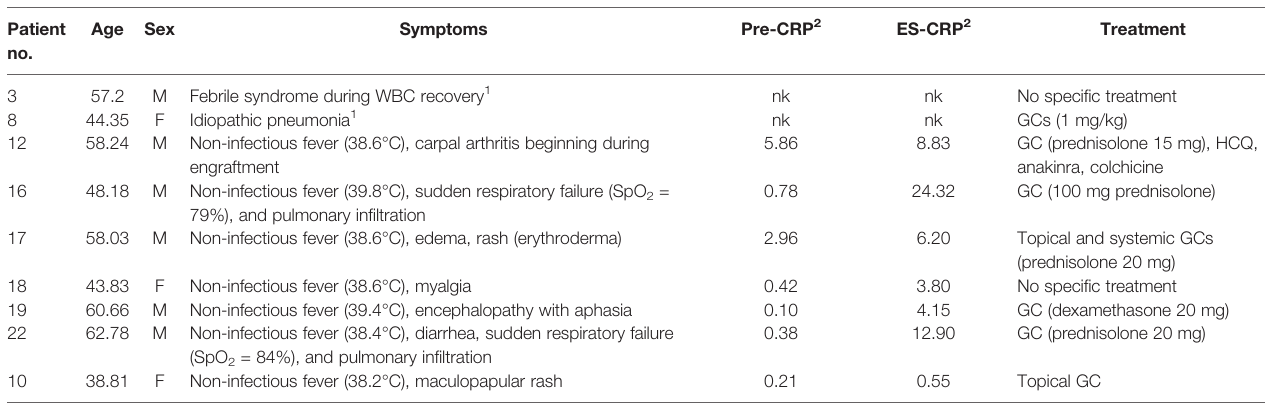
List of all patients with engraftment syndrome sorted by sex, age at transplantation, symptoms, pre-aHSCT CRP (at admission for aHSCT), CRP at manifestation of ES, and received treatment for ES. All patients had fever and increased CRP (relative to baseline CRP at admission) during manifestation of ES. S, sex; ES, engraftment syndrome; GC, glucocorticoid; HCQ, hydroxychloroquine; SpO 2 , oxygen saturation measured by pulse oximetry; nk, not known; aHSCT, autologous hematopoietic stem cell transplant; CRP, C-reactive